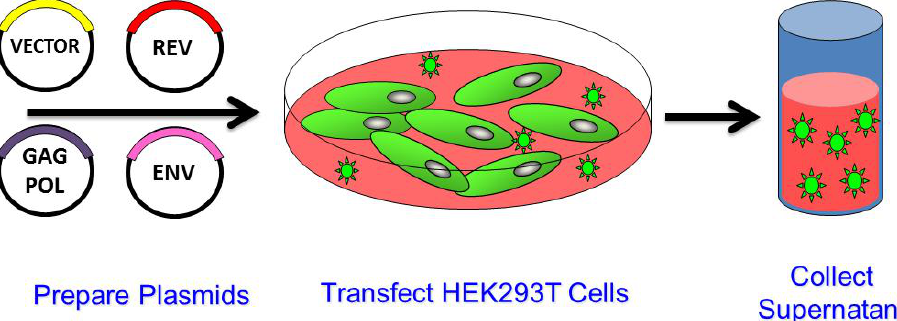
Figure 2. Generation of Lentiviral Vector by Transient Transfection. The four packaging plasmids are transfected into cells that have a high capacity for vector production. The most commonly used cell line is HEK293T. Maximal vector production occurs 48–72 h after transfection. The vector particles are released into the media which is collected and clarified of cell debris. Vector particles can be further purified and/or